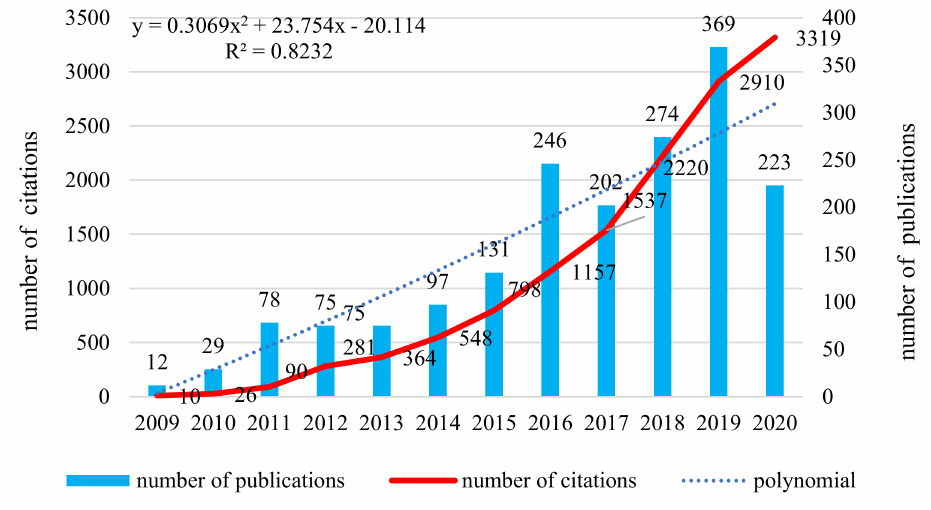
Figure 4. Distribution of scientific papers on smart grids (based on the Scopus